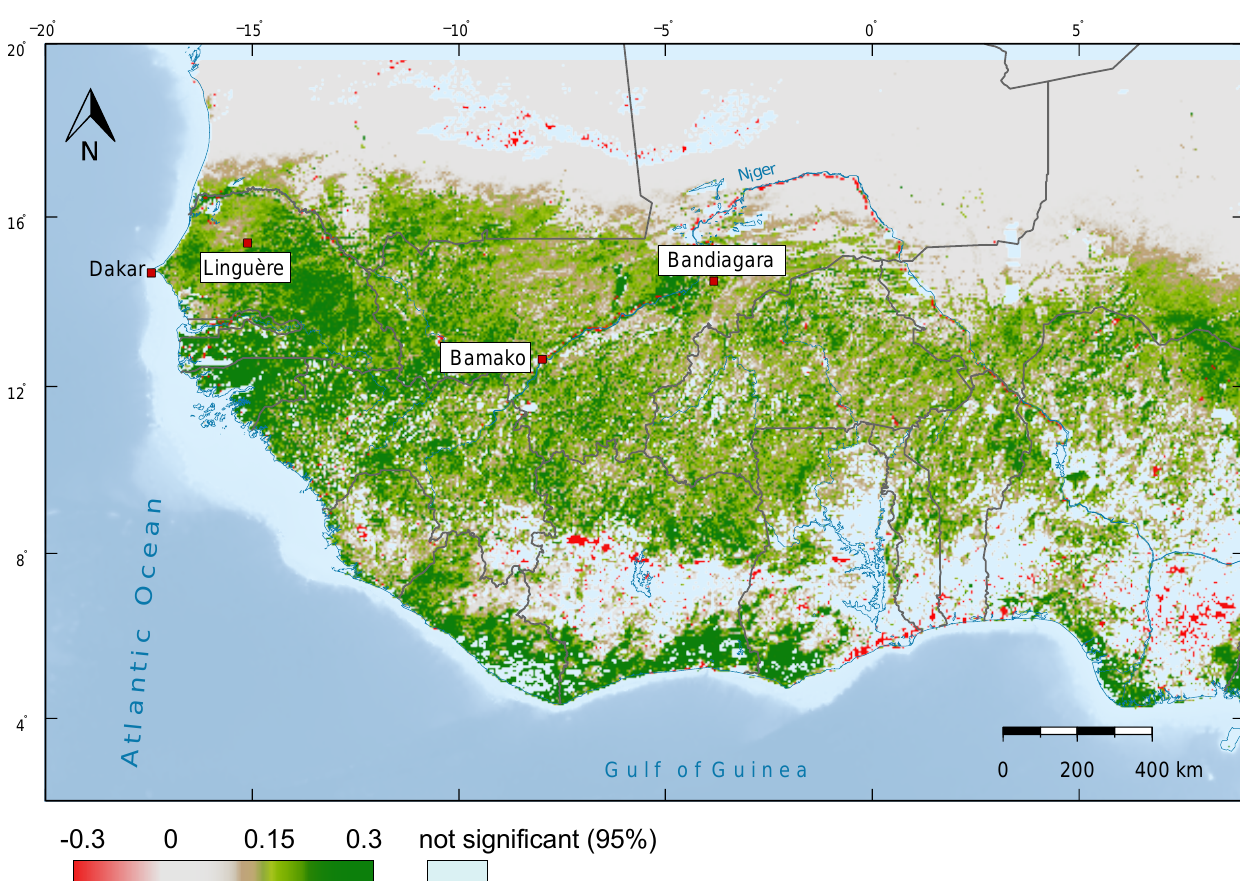
Figure 4. GEOV1 FAPAR change map of Western Africa (1982–2010). The map shows the slope of a linear regression with monthly MVCs multiplied by their number. Study areas are located around Lingu`ere and